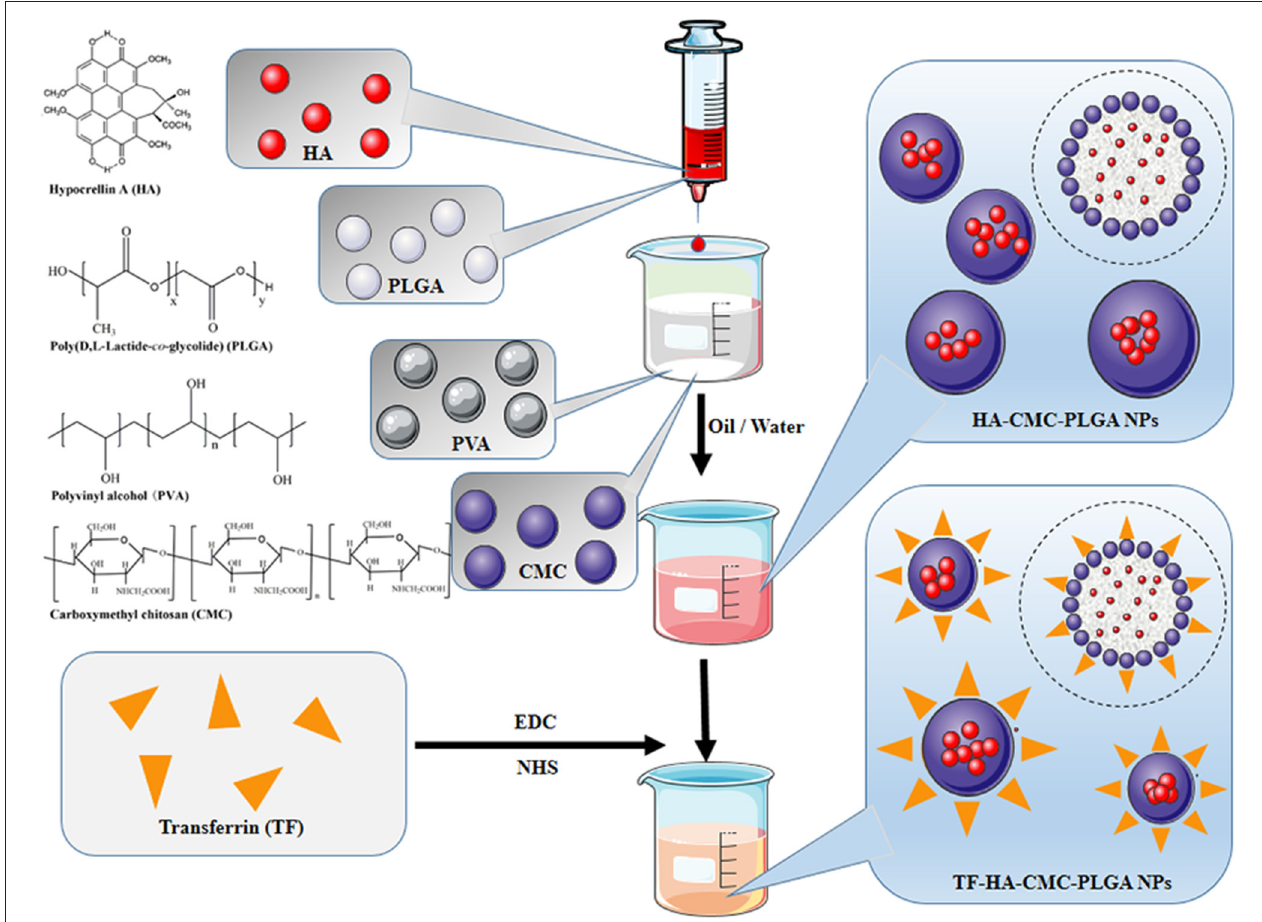
FIGURE 1 | Schematic of HA-CMC-PLGA NPs and TF-HA-CMC-PLGA NPs. HA-CMC-PLGA NPs were fabricated through oil-in-water (O/W) emulsion-solvent evaporation method. TF-HA-CMC-PLGA NPs were obtained by conjugation of TF to HA-CMC-PLGA NPs surface. Chemical structures of HA, PLGA, PVA, CMC